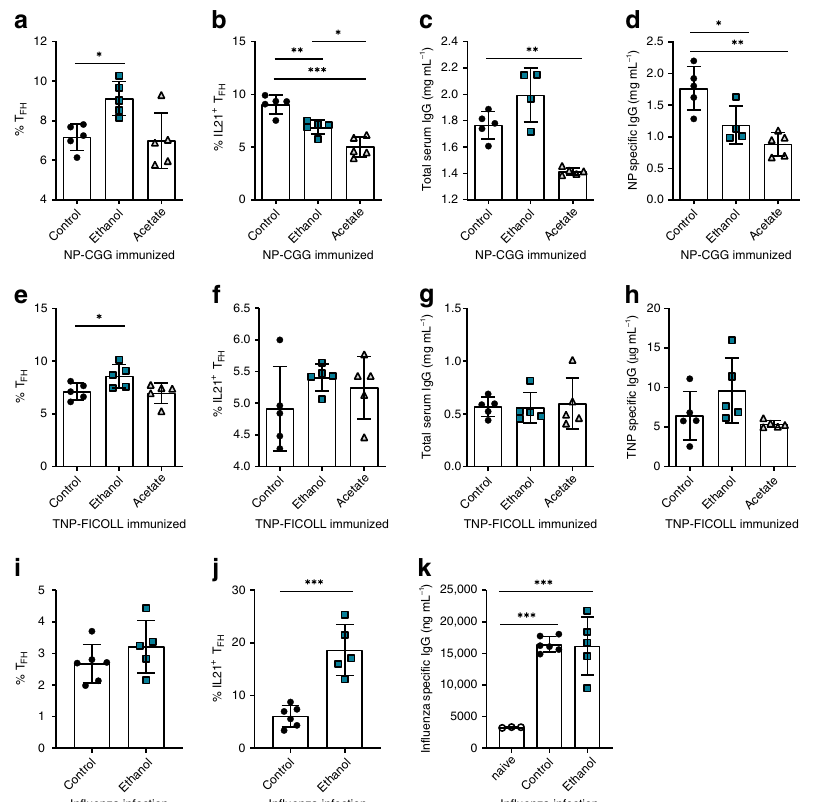
Fig. 6 Alcohol exposure affects T cell driven immune responses. a Total T FH (CD4 + B220 − PD-1 + CXCR5 + Bcl6 + ) cell numbers and b IL-21 producing T FH (CD4 + B220 − PD1 + CXCR5 + Bcl6 + IL-21 + ) cell numbers in spleens of NP-CGG immunized mice treated either with water (control) or ethanol or acetate. c Total serum IgG and d NP-speci fi c IgG levels in C57BL/6 mice immunized with NP-CGG (21 dpi). e Total T FH (CD4 + B220 − PD-1 + CXCR5 + Bcl6 +